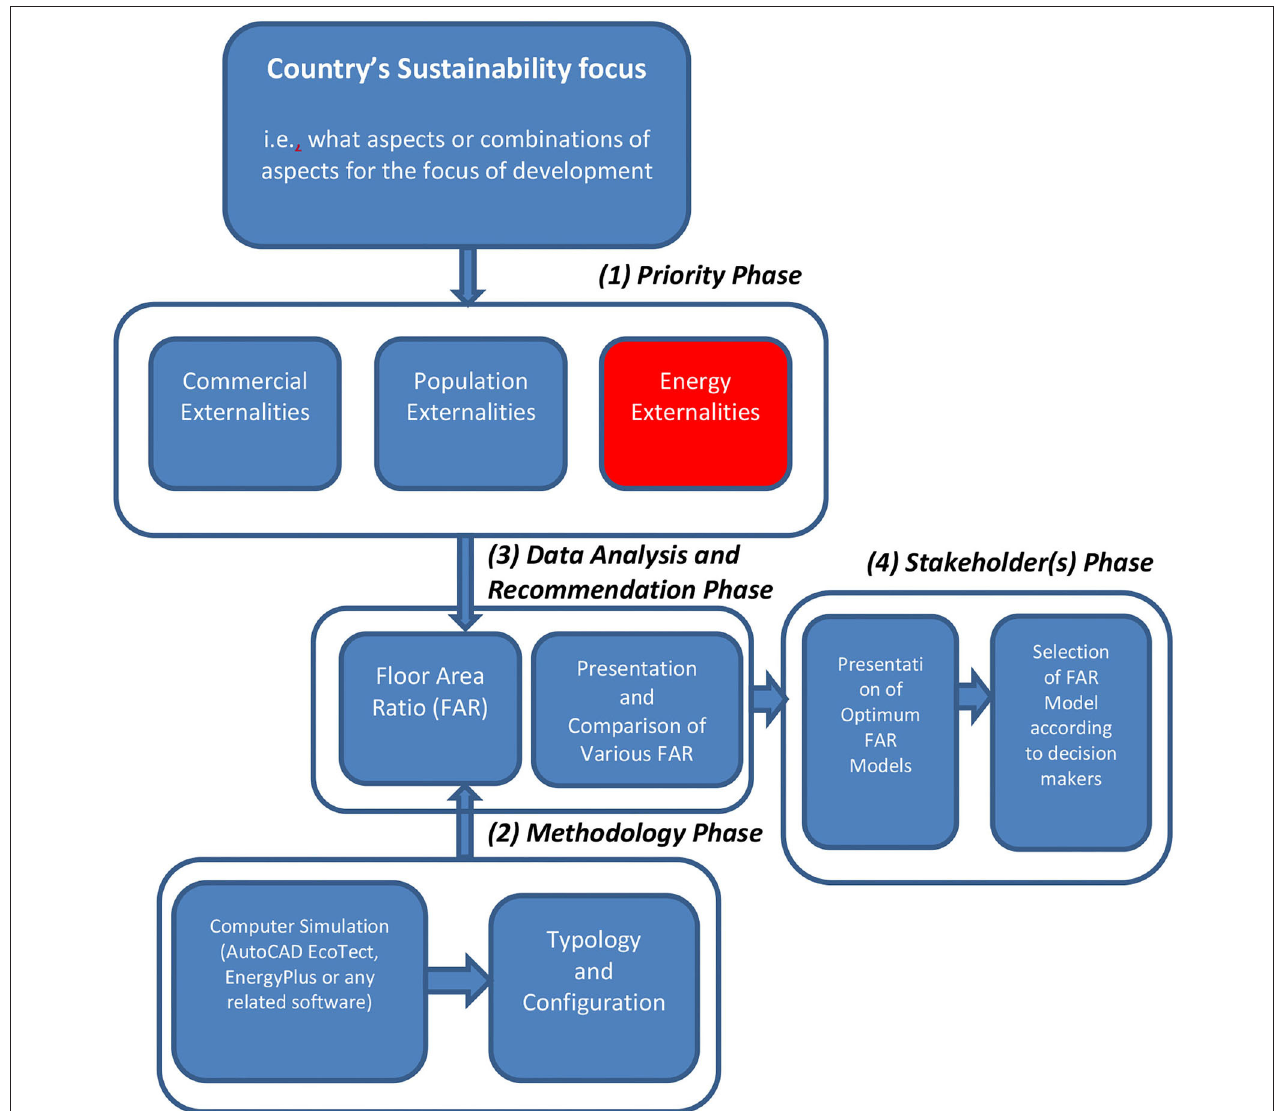
FIGURE 11 | Pre-assessment planning procedure for the utilisation of